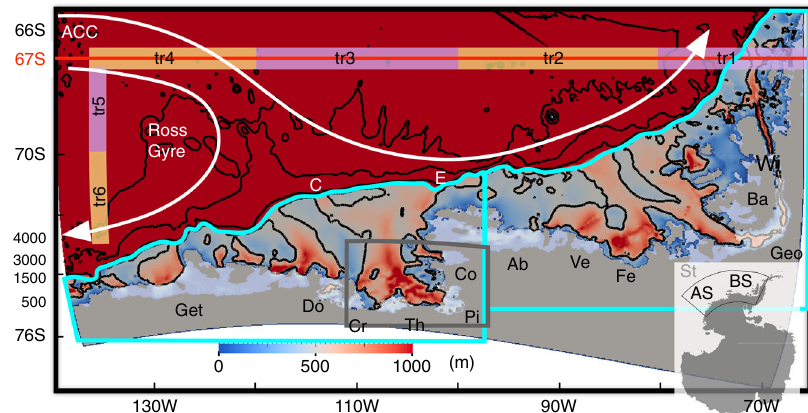
Fig. 1 Model bathymetry (color) and initial release locations of tracers representing Circumpolar Deep Water (CDW) (orange and purple boxes). Bathymetric contours of 500, 1500, 3000, and 4000 m are shown with black contours. The inset (right bottom) shows Antarctica with the region surrounded by black line denoting the model domain. The red line represents the vertical section shown in Fig. 2. White arrows indicate the Ross Gyre and the southern extent of the Antarctic Circumpolar Current (ACC) 1 . CDW tracers are integrated in the Amundsen Sea (AS) and Bellingshausen Sea (BS) domains enclosed by cyan lines indicating the continental shelf regions south of 700 m isobaths along continental shelf break. The time series of area- averaged CDW temperature and heat content for the eastern AS region are calculated for the region enclosed by the gray line. AS and BS denote the Amundsen Sea and Bellingshausen Sea. Letters E and C denote the submarine glacial troughs located on the eastern and central AS continental shelf, respectively. Locations of ice shelves are shown with white patches and acronyms are summarized in Supplementary Table